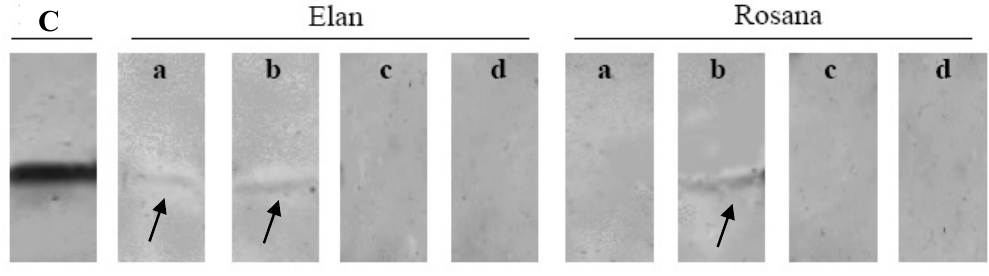
Figure 2. Influence of TCA-precipitation and sample preparation procedures on the detection of strawberry LTP (Fra a 3) from two different cultivars (Elan and Rosana) using four different sample preparation procedures: a) 1% SDS + 50 mM DTT, b) 7 M urea + 50 mM DTT, c) 1% SDS, d) 7 M Urea; C: native apple LTP as positive control.